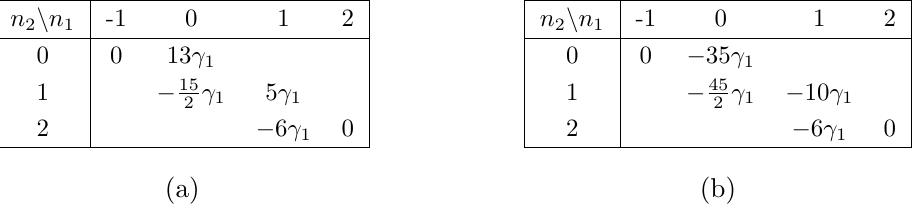
Table 7 . After setting (cid:21) = 0 we can get the number of families in the F-theory limit (a) The net number of families as a function of the parameter (cid:13) 1 . (b) The di(cid:11)erence among the chiralities for the split matter curves (cid:1) (cid:31) ( 3 ; 1 ) = (cid:31) ( 3 ; 1 ) 1 = 3 (cid:0) (cid:31) ( 3 ; 1 ) 1 = 3 . Recall that the chiral index for 1 = 3 (1 ; (cid:0) 1) (0 ; 2) the (cid:12)eld ( 3 ; 1 ) is given as (cid:31) ( 3 ; 1 ) = (cid:0) (cid:31) ( 3 ; 1 ) 1 = 3 (cid:0) (cid:31) ( 3 ; 1 ) 1 = 3 1 = 3 1 = 3 (1 ; (cid:0) 1) (0 ; 2)